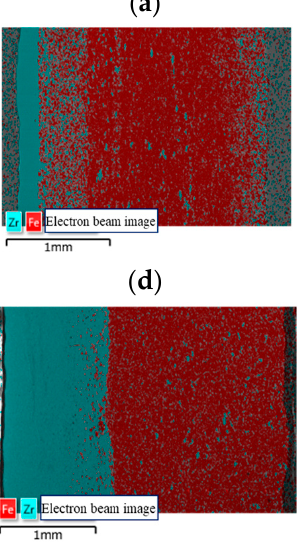
Figure 8. EDX element mapping results for samples with the rotating speed of 250 rpm for different amounts of PCA dispersant. ( a ) PCA (0%), ( b ) PCA (1%), ( c ) PCA (3%), ( d ) PCA (5%), ( e ) PCA (10%), ( f ) PCA (20%).